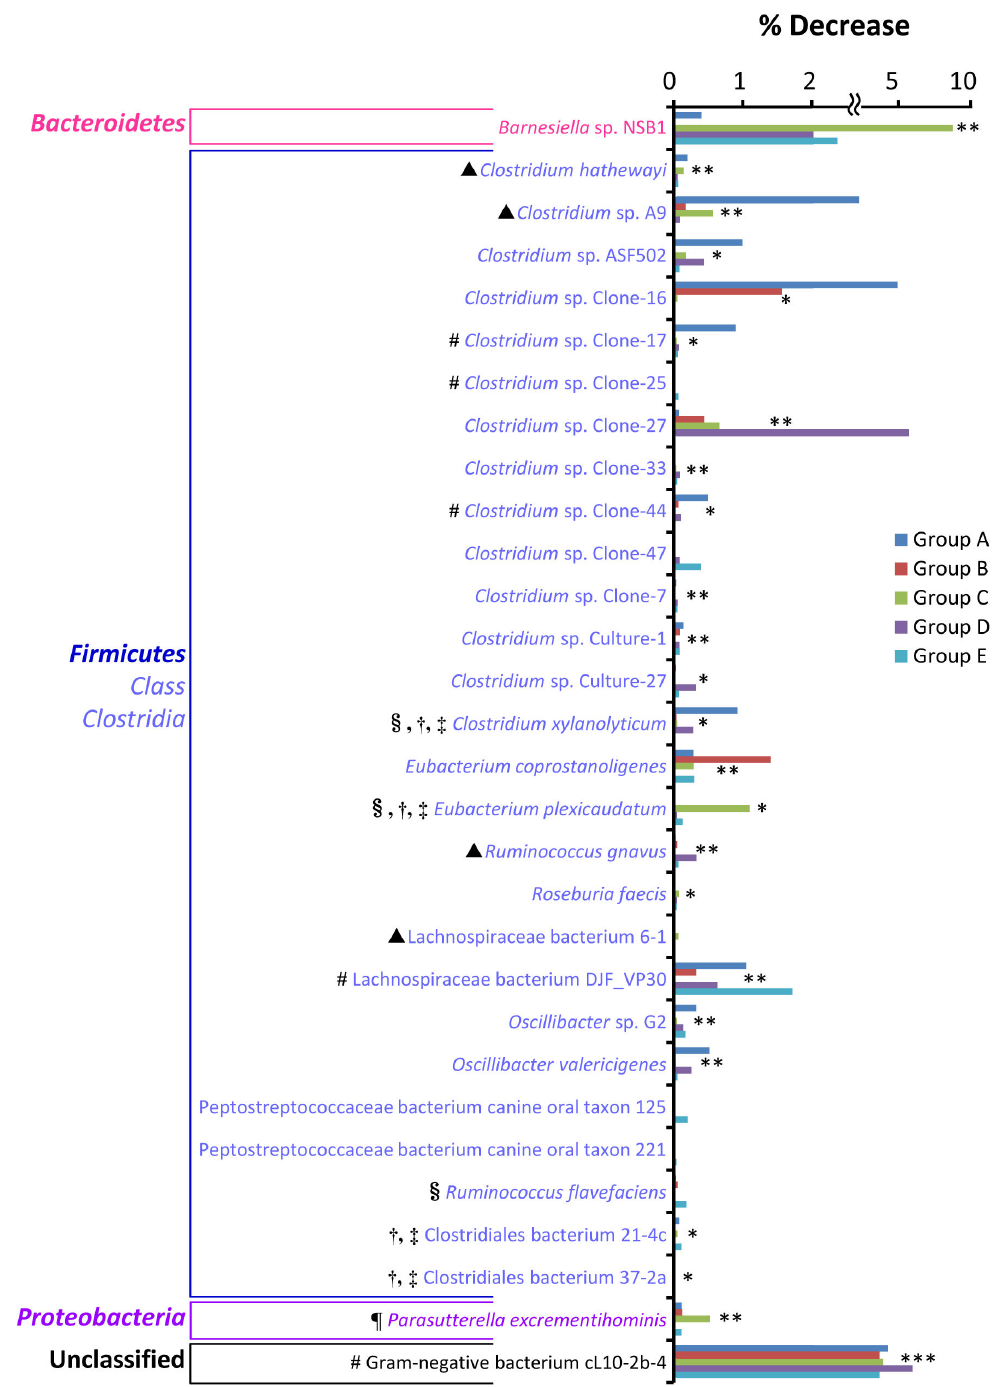
Figure 6. Bacterial phylotypes in the large intestine whose population level decreased upon PG-administration. Percent decrease was calculated by subtracting the percent population level of each specific phylotype found in the PBS control mice with that found in the PG-administered mice. Associations between bacterial phylotypes and PG administration were examined by Fisher exact test. The phylotypes having P values less than 0.05 at least in 2 groups (see Table S9) are shown. Asterisks *, ** and *** indicate bacterial phylotypes having P values less than 0.05 in 3, 4 and 5 groups, respectively. #: Bacteria whose population level also increased in the small intestine (see Figure 3), §: saccharolytic bacteria, †: short-chain fatty acids-producing bacteria, ‡: bacteria with immunomodulatory effect, ¶: asaccharolytic bacteria, ▲: disease-associated bacteria. doi: 10.1371/journal.pone.0075008.g006 PLOS ONE |